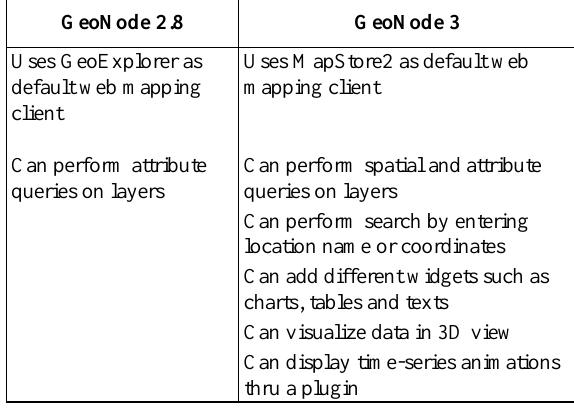
Table 5 . Comparison of GeoNode 2.8 and GeoNode